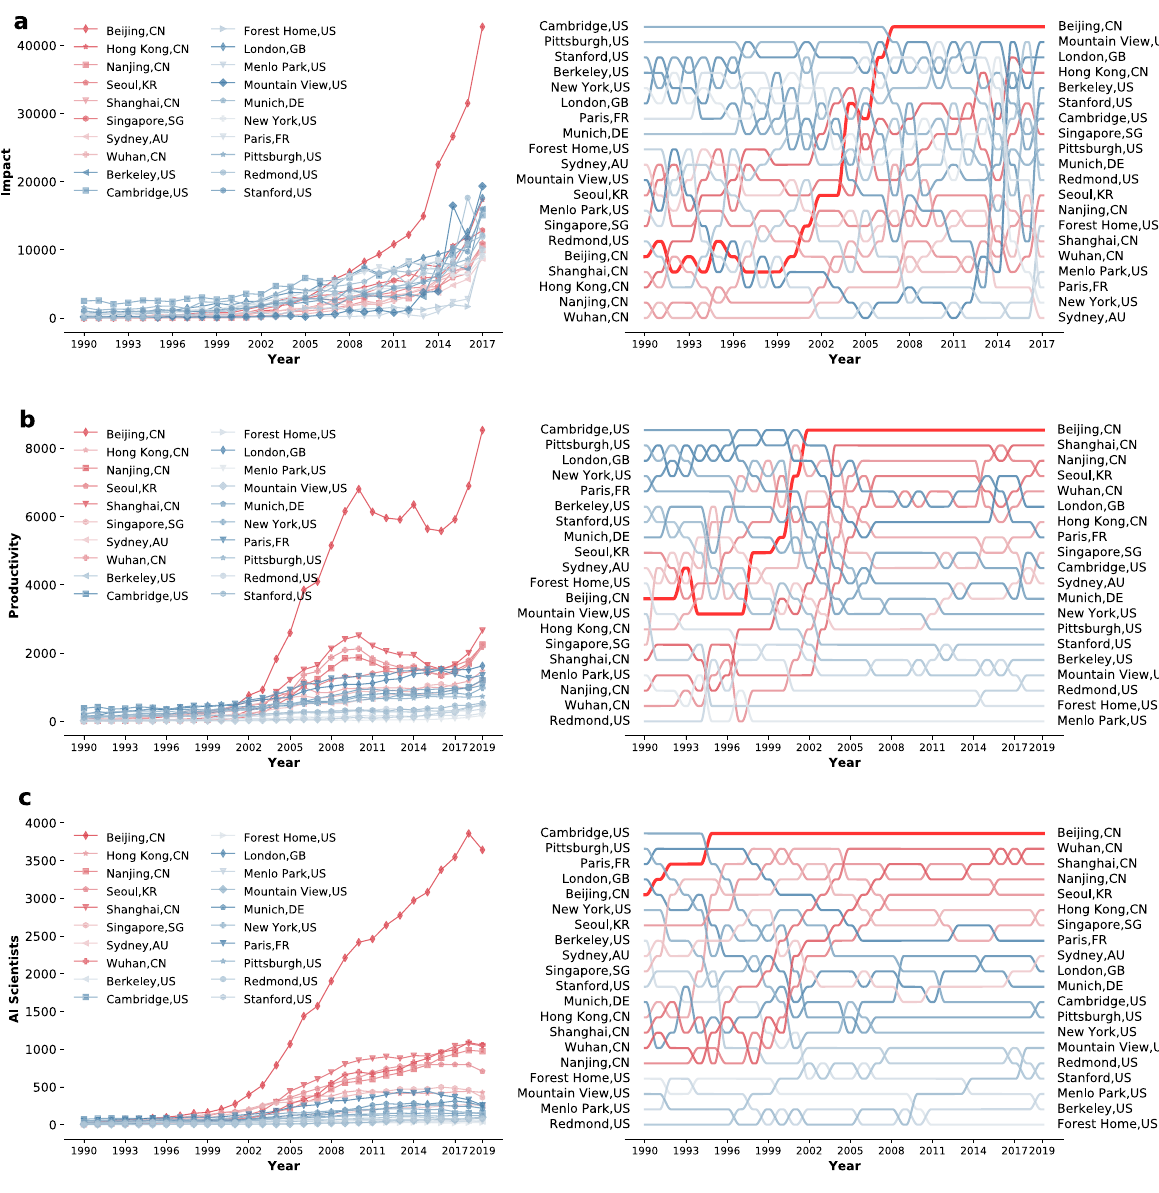
Figure 1. Comparing cities in terms of AI impact, AI productivity, and number of AI Scientists. All subfigures consider the same 20 cities, which were the most impactful in AI in 2017. Cities in the U.S. or Europe are classified as “Western” and colored in blue, while the remaining cities are classified as “Eastern” and colored in red. ( a ) Left panel: AI impact from 1990 to 2017, where greater color intensity indicates greater impact; Right panel: Similar to the left panel, but depicts the relative, rather than the absolute, difference between cities each year. ( b ) Left panel: AI productivity from 1990 to 2019, where greater color intensity indicates greater productivity; Right panel: Similar to the left panel, but depicts the relative, rather than the absolute, difference between cities each year. ( c ) Left panel: Number of AI Scientists from 1990 to 2019, where greater color intensity indicates greater number of AI Scientists; Right panel: Similar to the left panel, but depicts the relative, rather than the absolute, difference between cities each